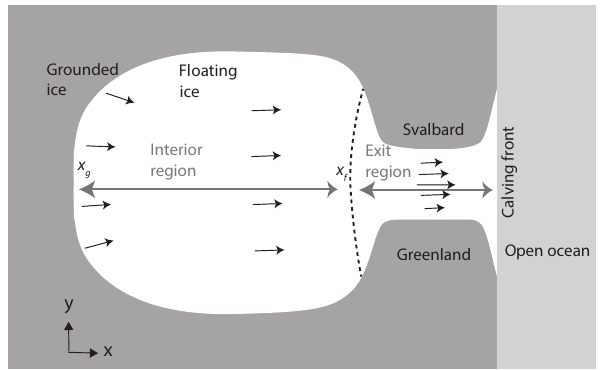
Figure 2. Outline of the two dynamical zones in the Arctic Ocean ice shelf, divided by the dashed line. The interior “dammed” ice- shelf region, where the ice thickness is nearly uniform and con- trolled by the horizontally integrated mass balance (Eqs. 19 and 21), comprises the bulk of the ice-shelf area and is subjected to pro- nounced back stress from the Fram Strait constriction. The exit re- gion in the Fram Strait area, which terminates at a calving front, has dynamical similarities with moderately embayed large Antarc- tic ice shelves. The black arrows indicate ice flow and the two double-headed arrows are along the x – z transect shown in Fig. 3. In most of the exit region, there is an approximate balance between lateral shear stress and hydrostatic pressure gradient (Eq. 23), but the leading-order ice-shelf momentum balance changes closer to the calving front (Hindmarsh,